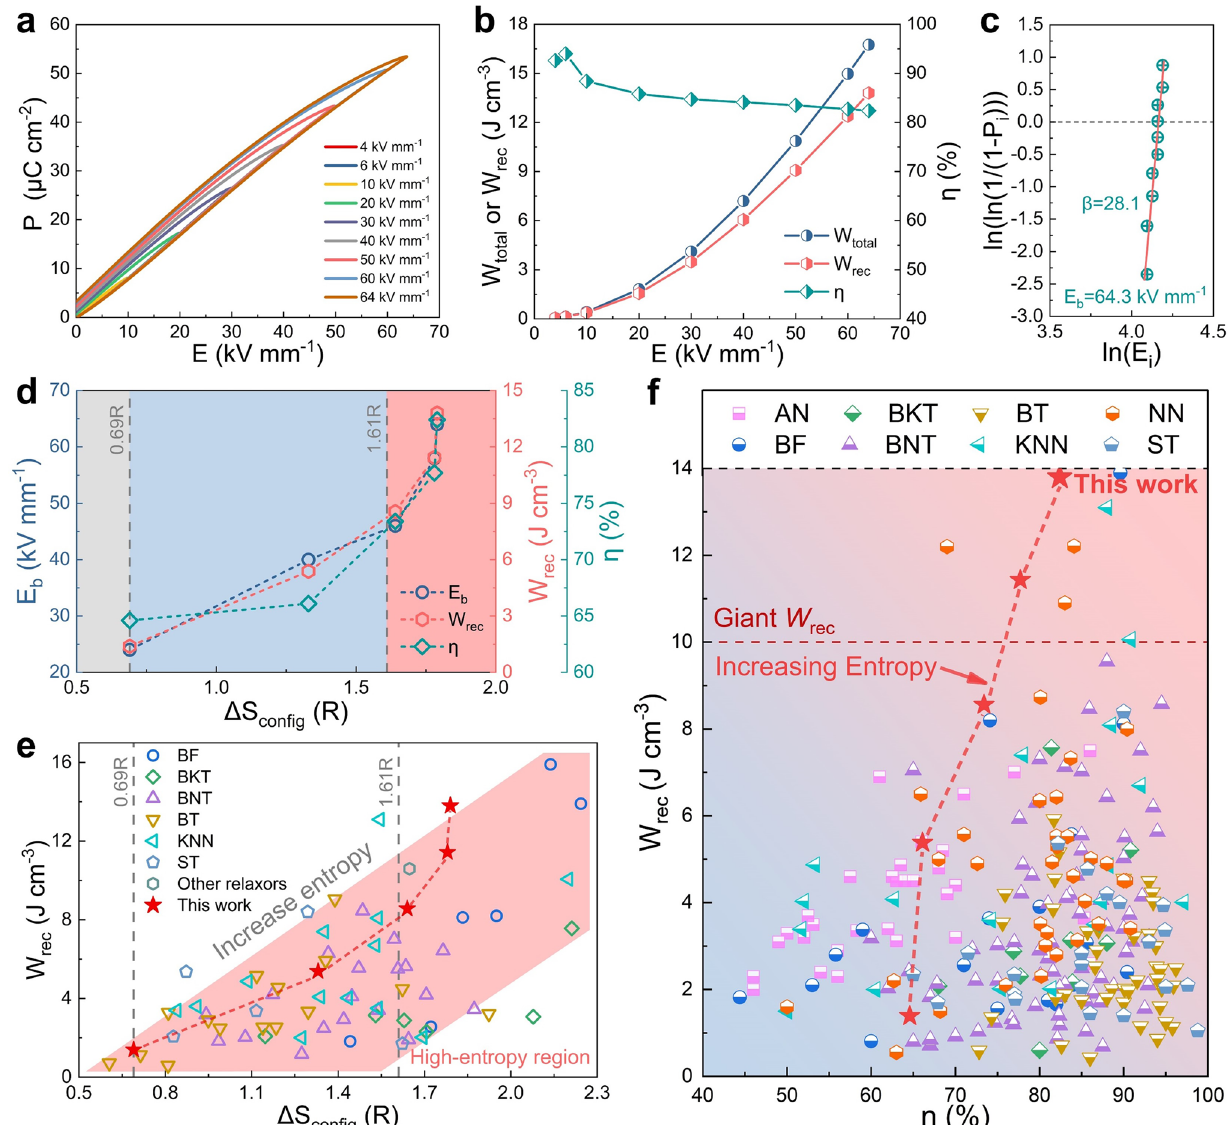
Fig. 2 Ultrahigh energy storage performance by increasing configuration entropy. ( a ) P - E loops, and ( b ) W rec and η of BNTFN-1/3 ceramics under various electric fields. ( c ) Weibull distribution of E b for BNTFN-1/3 ceramics. ( d ) E b , W rec , and η as a function of Δ S config for BNTFN- 1/3 ceramics. ( e ) A comparison of W rec and Δ S config between the studied samples in this work and other reported lead-free relaxor ferroelectric ceramics. ( f ) A comparison of W rec and η between the studied samples in this work and other reported lead-free ceramics (AN: AgNbO 3 ; BKT: Bi 0.5 K 0.5 TiO 3 ; BT: BaTiO 3 ; KNN: (K,Na)NbO 3 ; ST: SrTiO 3